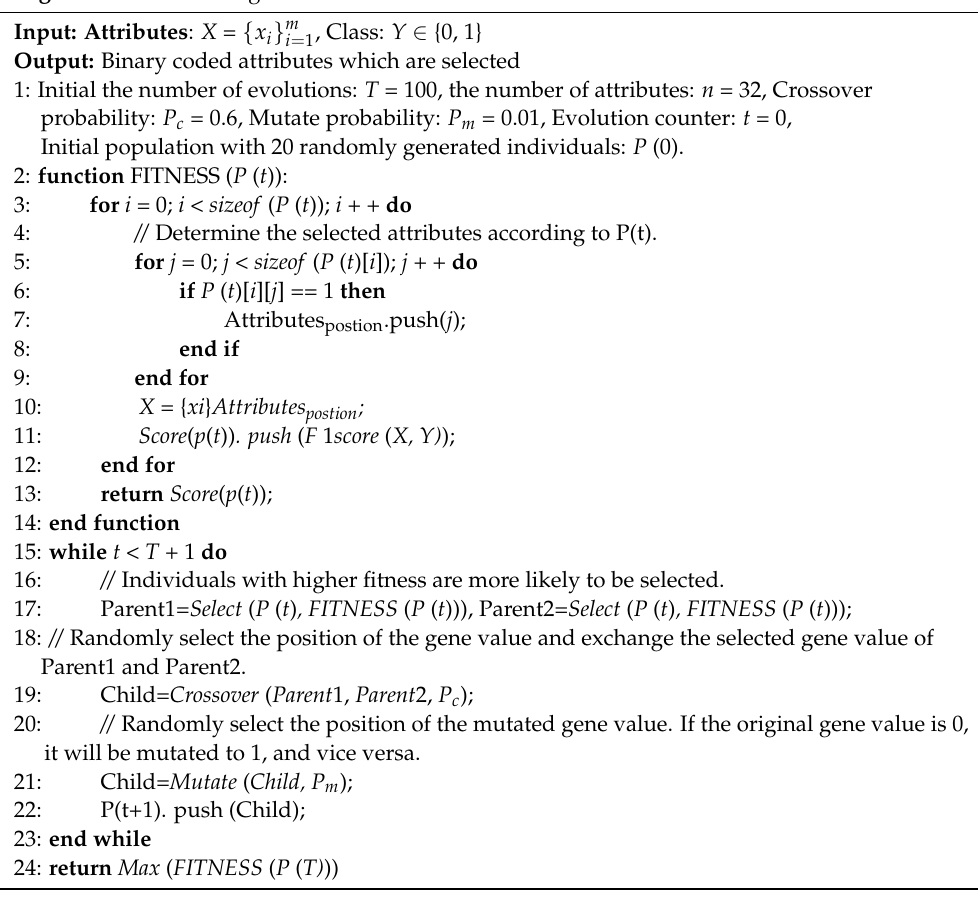
Algorithm 1 Genetic Algorithm for the feature selection in classifiers based on Decision